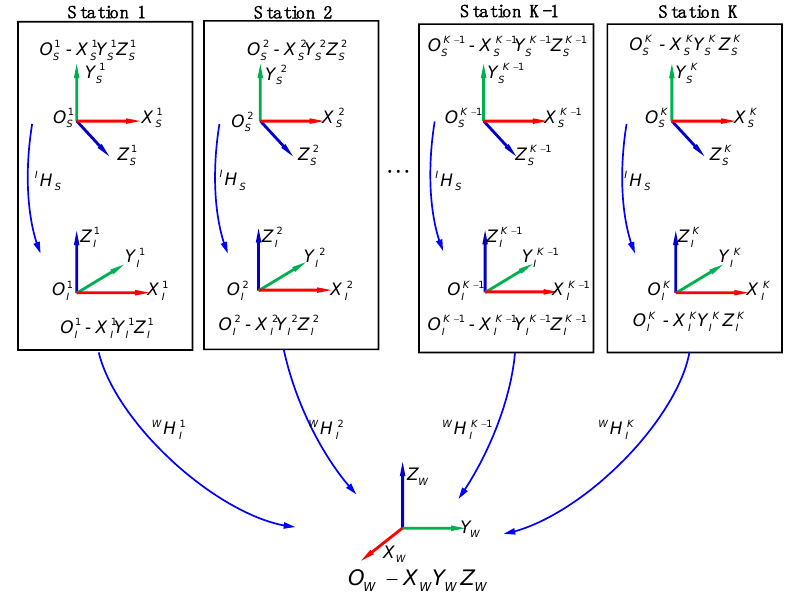
Figure 2. Schematic of the combined measurement model.